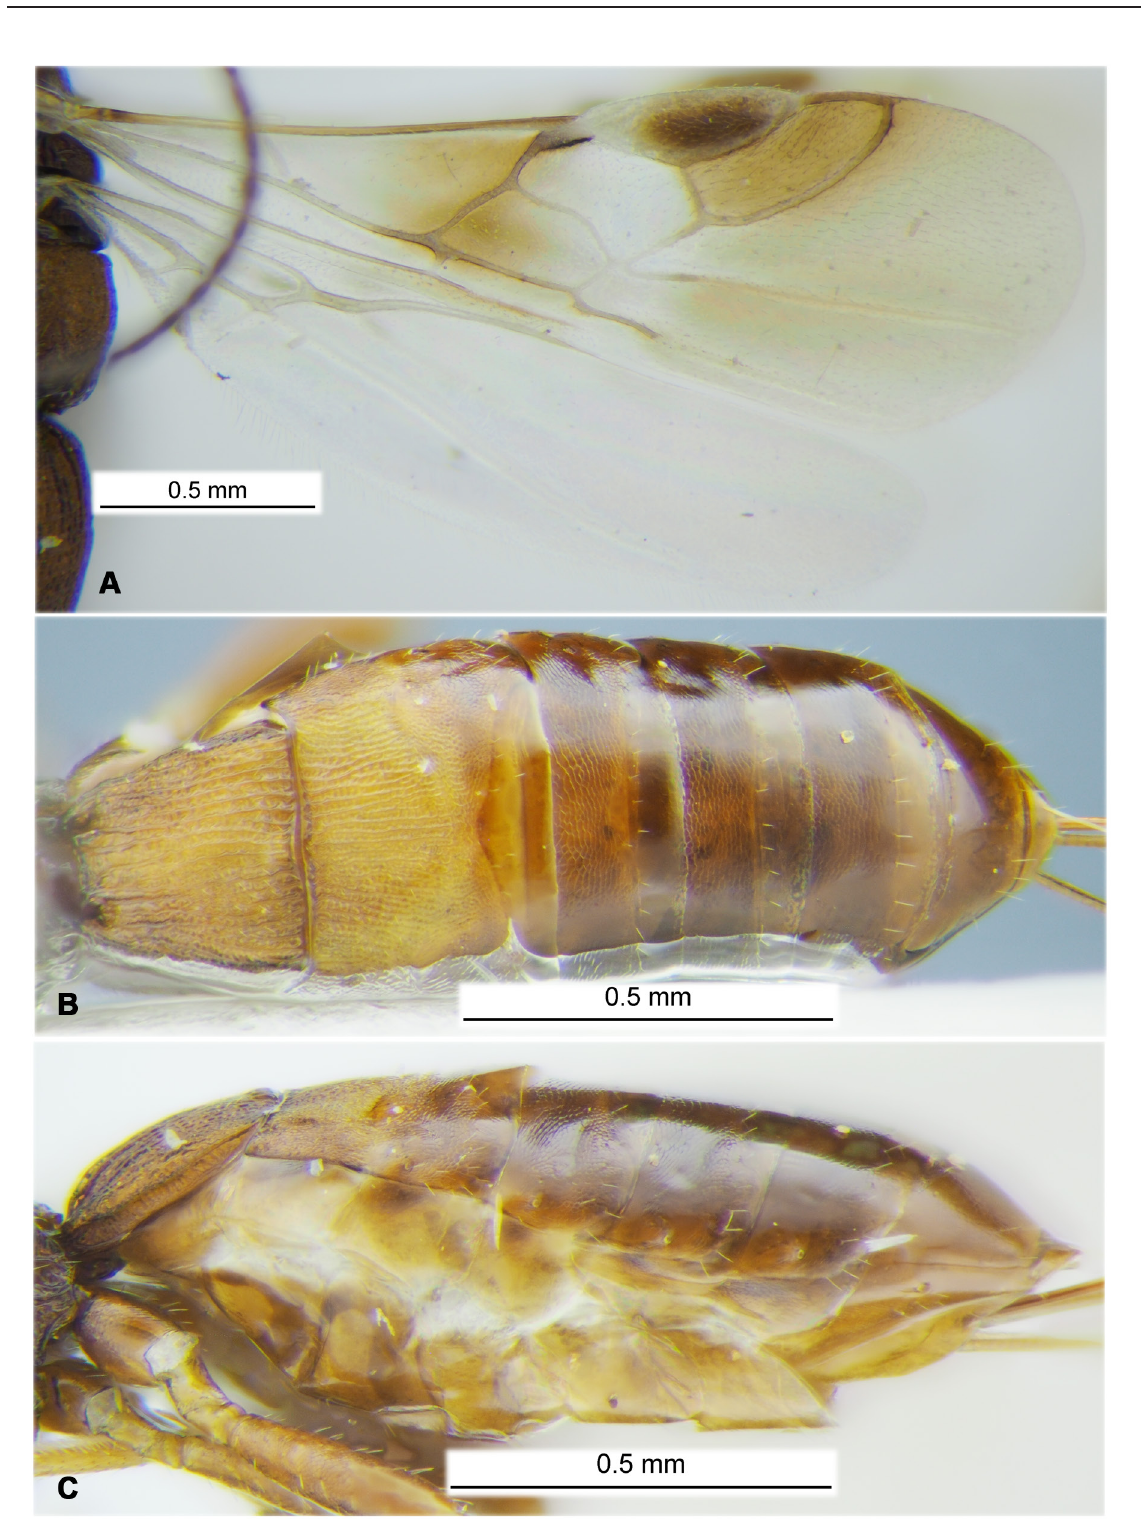
Fig. 29. Hecabalodes maculatus Belokobylskij sp. nov., holotype, ♀ (RMNH). A . Wings. B . Metasoma, dorsal view. C . Metasoma, lateral